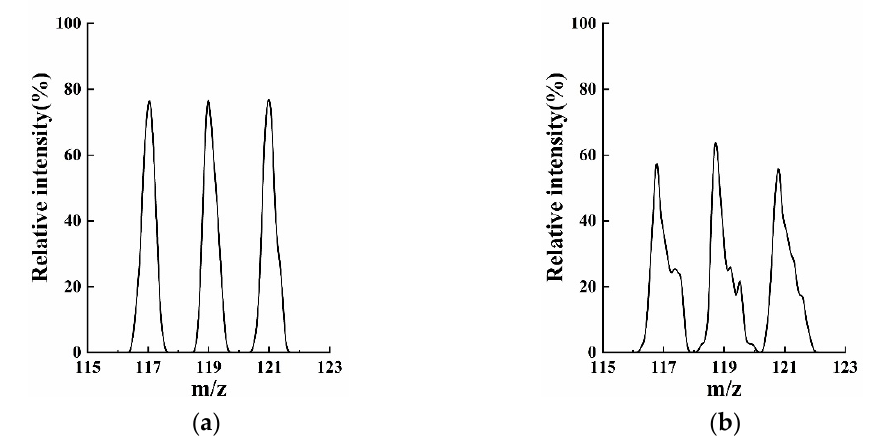
Figure 5. Mass spectrum of 2-slit model ( r x = 1.4 mm) when ( a ) Δ r y = 1.6 mm; ( b ) Δ r y = 1.7 mm. Lower full width at half maximum (FWHM) with severe distortion limited the MS capability.